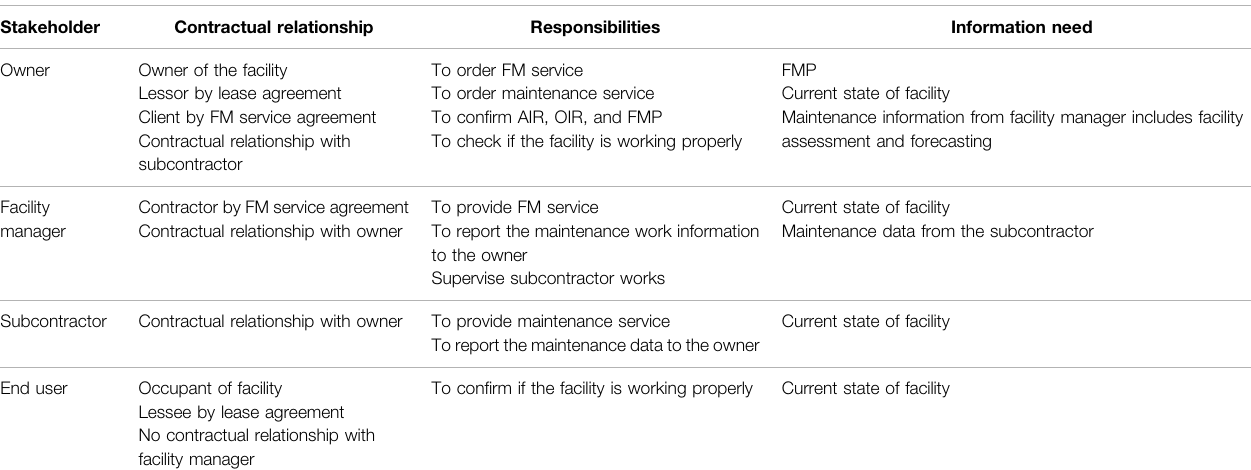
TABLE 1 | Roles and responsibilities of the FM